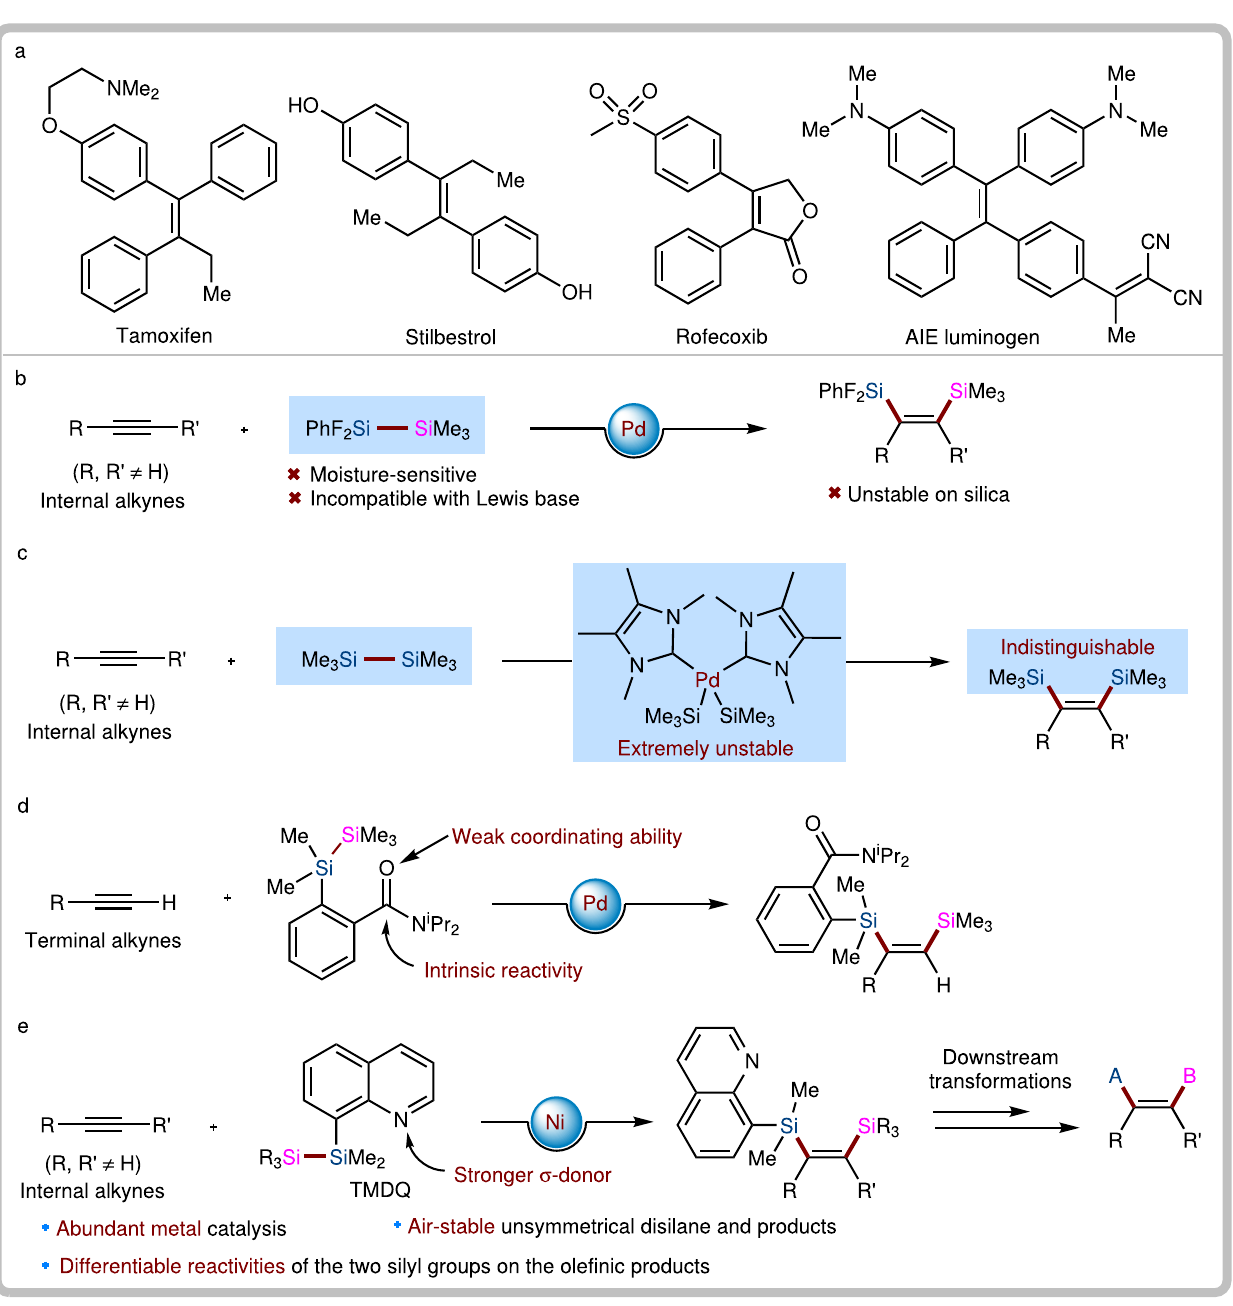
Fig. 1 Research background and our study on Ni(0)-catalyzed bis-silylation of internal alkynes with unsymmetric disilanes. a Some multi-substituted alkenes as drugs and luminogens. b The seminal report on bis-silylation of internal alkynes with acyclic disilanes (Ozawa ’ s work). c The breakthrough on bis-silylation of internal alkynes with stable disilanes (Spencer ’ s work). d Development of directing group-activated air-stable disilane for bis-silylation. e Bis-silylation of internal alkynes with air-stable disilane enabled by Ni(0) catalysis (this